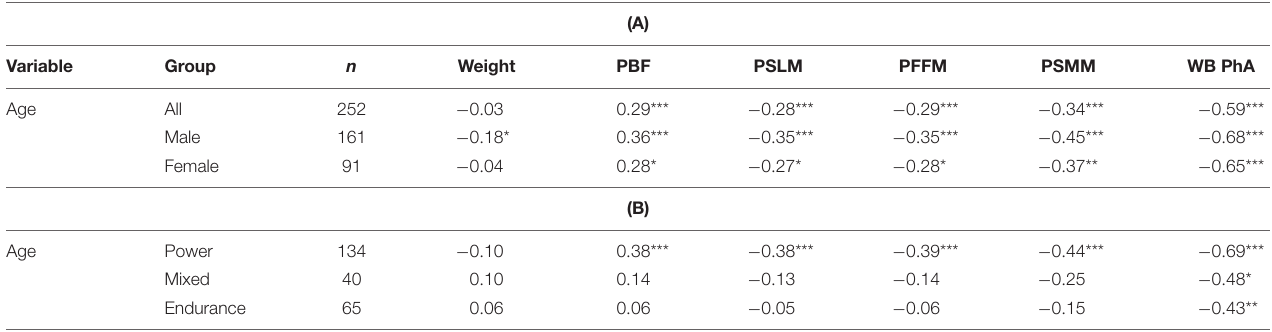
TABLE 4 | (A) Spearman’s rank correlation coefficients between age and body composition stratified by sex. (B) Spearman’s rank correlation coefficients between age and body composition stratified. (A) Variable Group n Weight PBF PSLM PFFM PSMM WB PhA